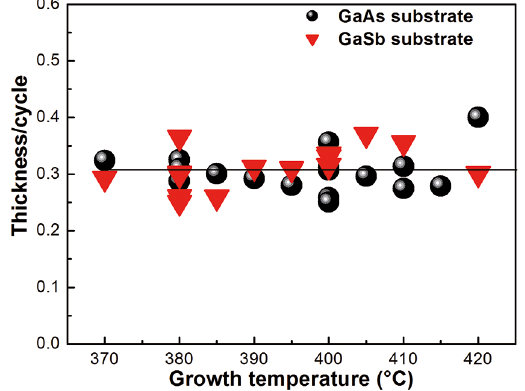
Figure 3: X-ray diffractograms of ZnTe grown on GaAs, peak position shift is related with the growth temperature and with the layer